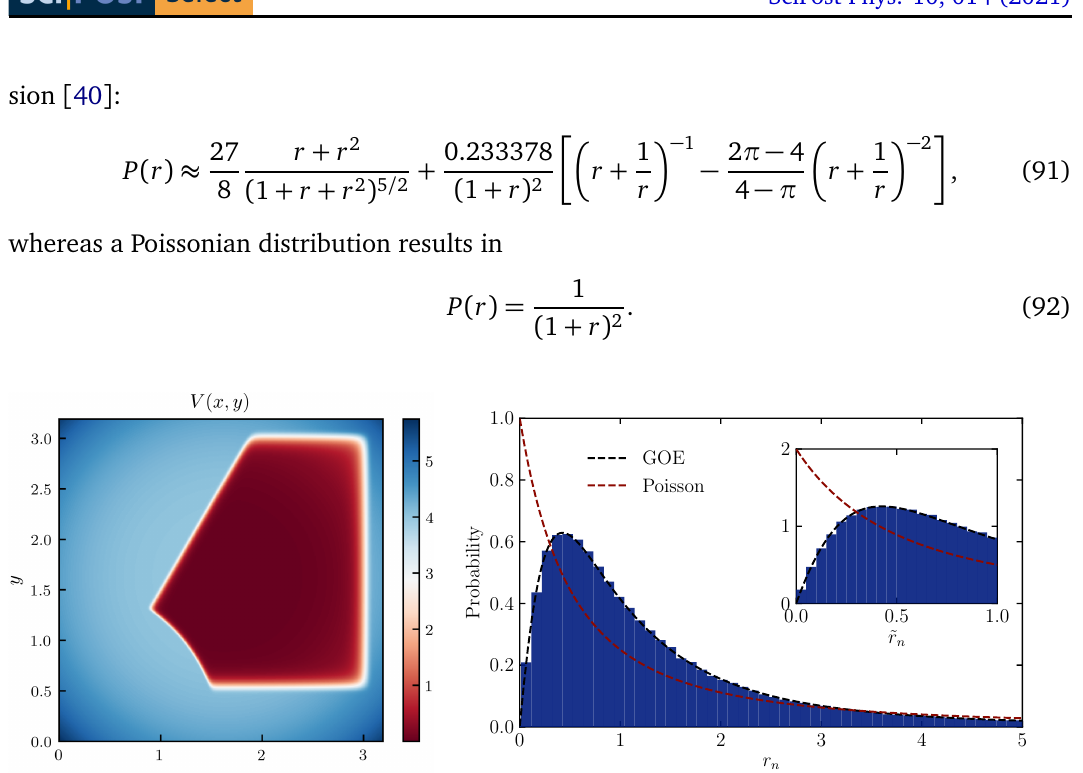
Figure 10: Distribution of the ratio of consecutive level spacings . Left: The chaotic two-dimensional potential representing a series of smoothened step func- tions in an additional weak confining potential. Right: Histogram of the ratio of the consequent difference of the (logs of) eigenvalues (see Eq. (90)) of the canonical distribution W for a particle in this potential. The black dashed line is the analytic approximation to the GOE distribution taken from Ref. [ 40 ] and the red dashed line is the expected result for Poissonian statistics (92). Inset details the distribution of = min ( r ) ˜ r ,1 / r n n n